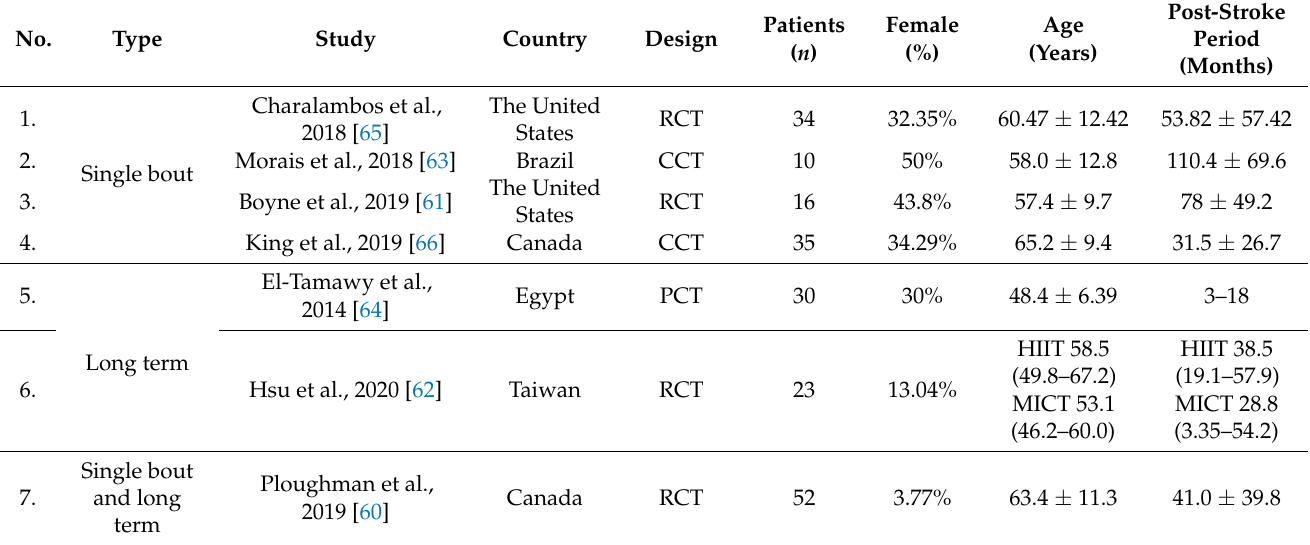
Table 1. Characteristics of the included